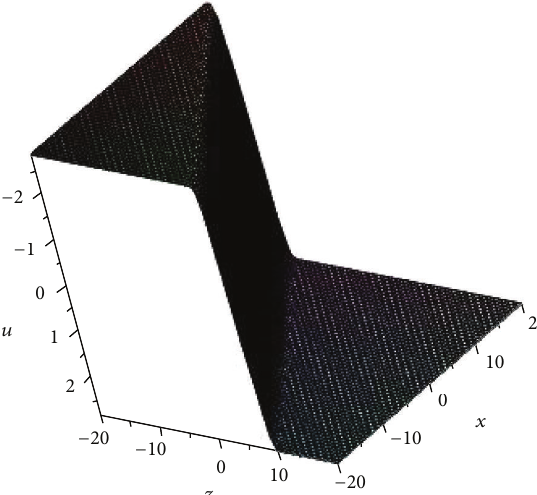
Figure 1: The shape of the 1-soliton to (1) with 𝜆 1 = −2 , 𝑦 = 0 , 𝑡 = 1 , = 0 . 𝛾 1